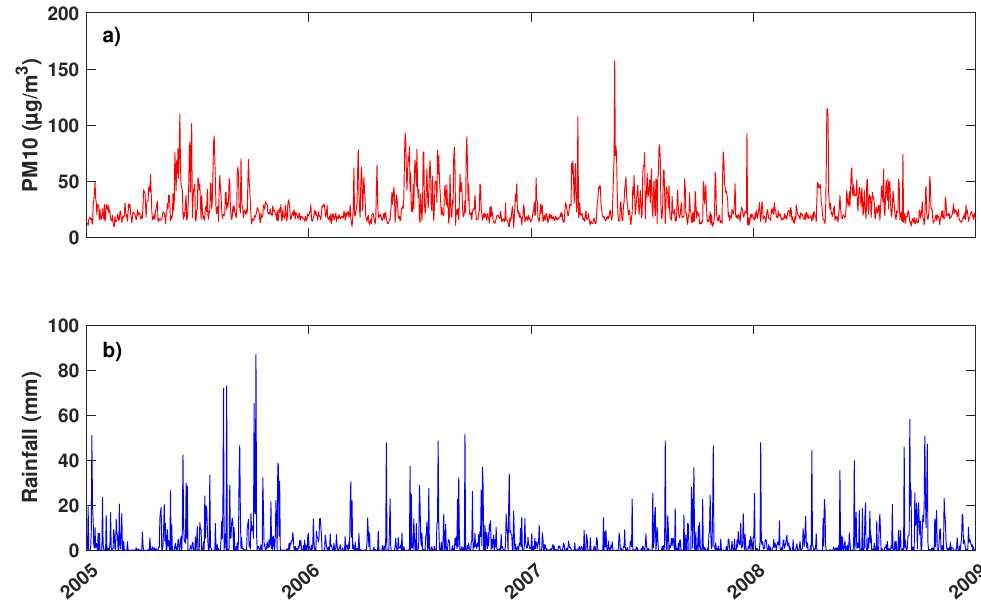
Figure 1. Examples of synchronous time series between ( a ) daily average PM 10 concentrations and ( b ) the daily sum of rainfall between 2005 and